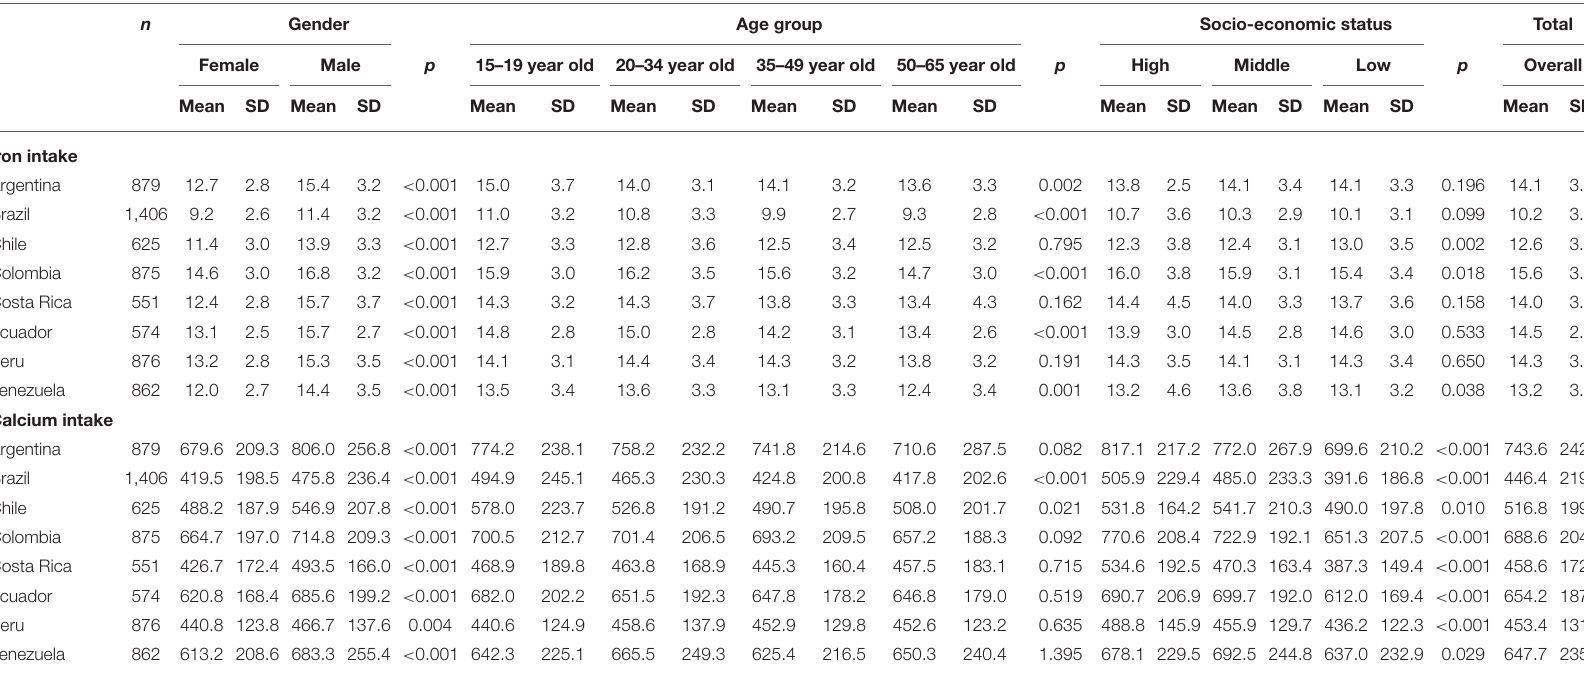
TABLE 2 | Iron and calcium intakes (mg) by country between gender, age group, and socioeconomic status in the Latin American Study of Nutrition and Health (ELANS) * . n Gender Age group Socio-economic status Total Female Male p p High Middle Low p